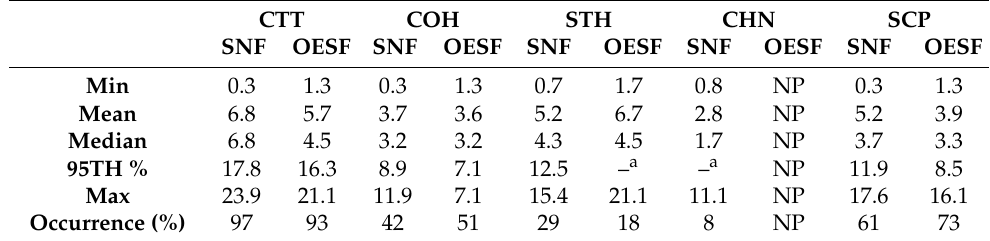
Table 1. Stream gradient (%) and occurrence of fish encountered in surveys conducted on the Siuslaw National Forest (SNF, n= 226) and Olympic Experimental State Forest (OESF, n= 55). CTT = coastal cutthroat trout, COH = coho salmon, STH = steelhead, CHN = Chinook salmon, SCP = sculpin, NP = not